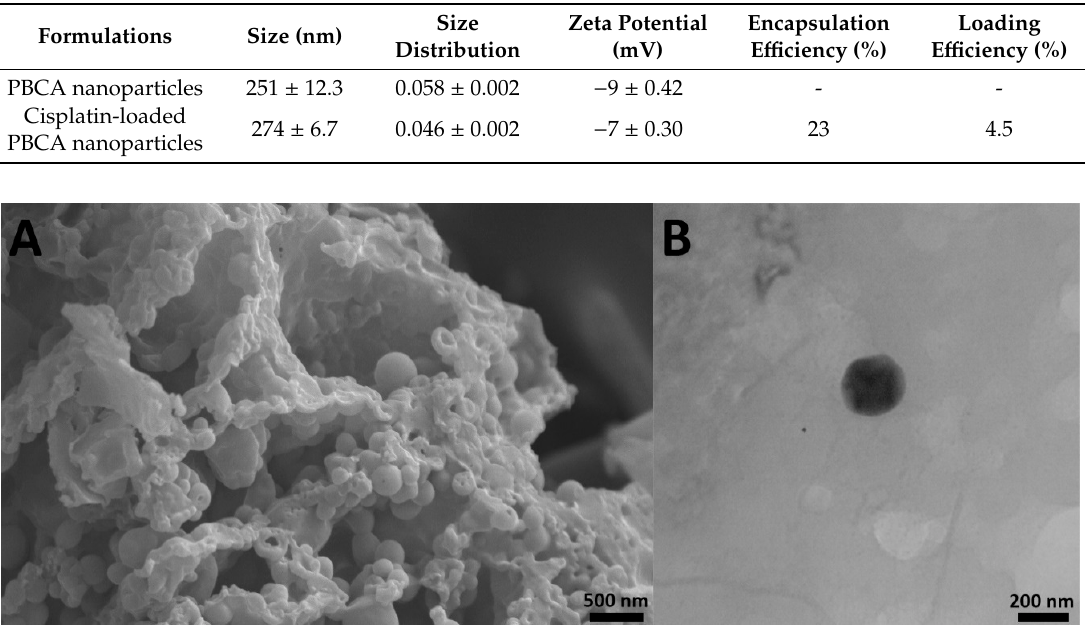
Table 1. Size, size distribution, and zeta potential of blank and cisplatin-loaded PBCA nanoparticles and encapsulation and loading e ffi ciencies of cisplatin-loaded PBCA nanoparticles.